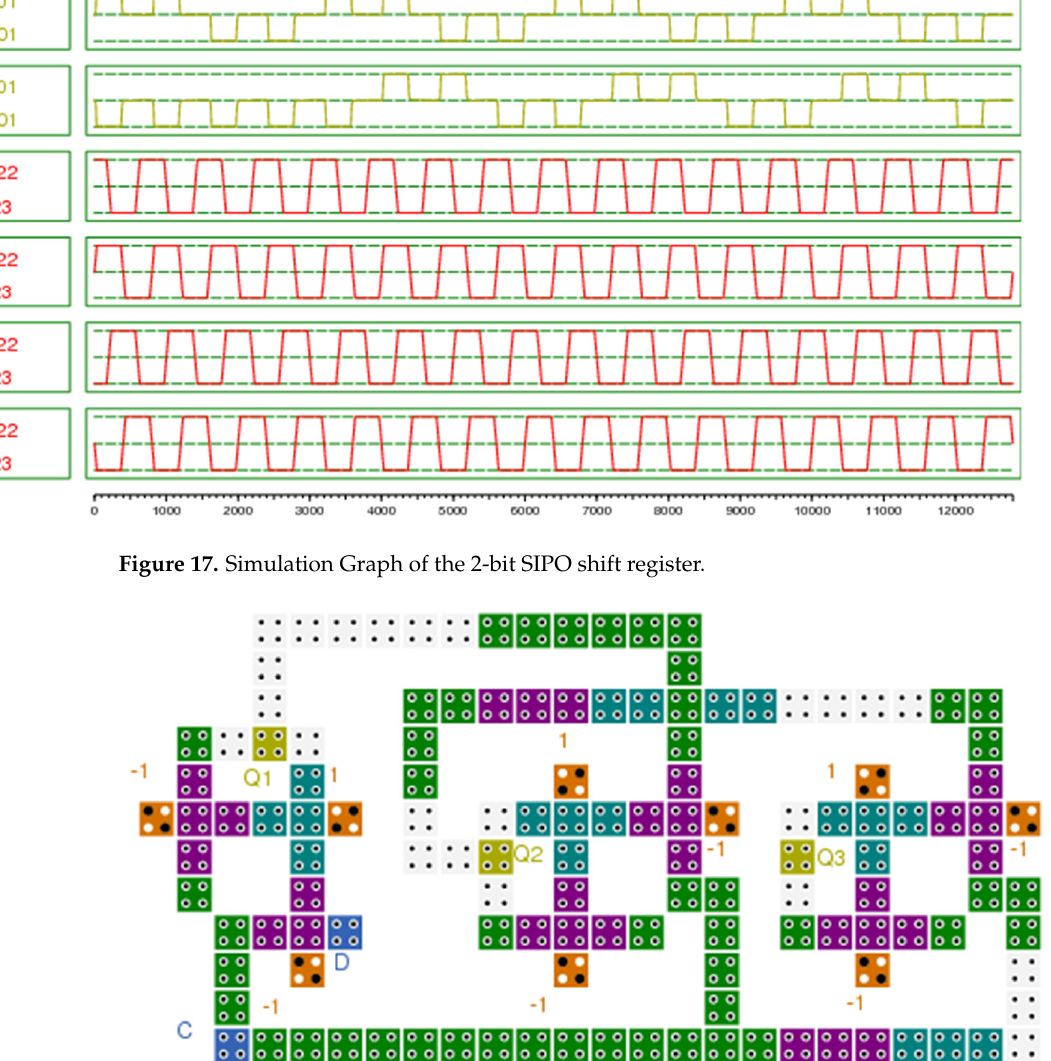
Figure 18. QCA Implementation of 3-bit SIPO shift register.